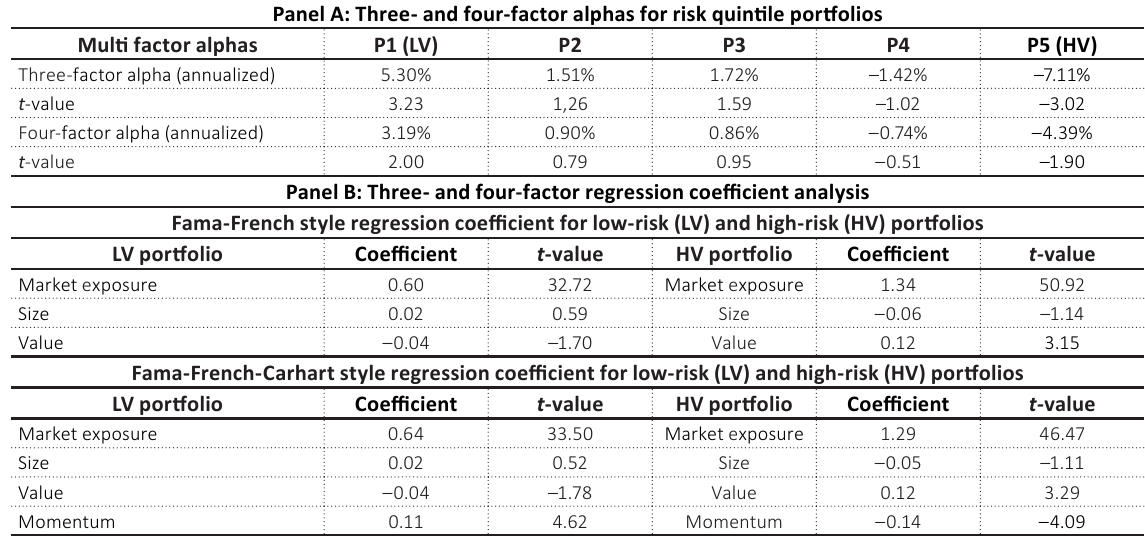
Table 2. Three - factor (Fama-French) and four - factor (Fama-French-Carhart) style regression analysis for risk quintile portfolios